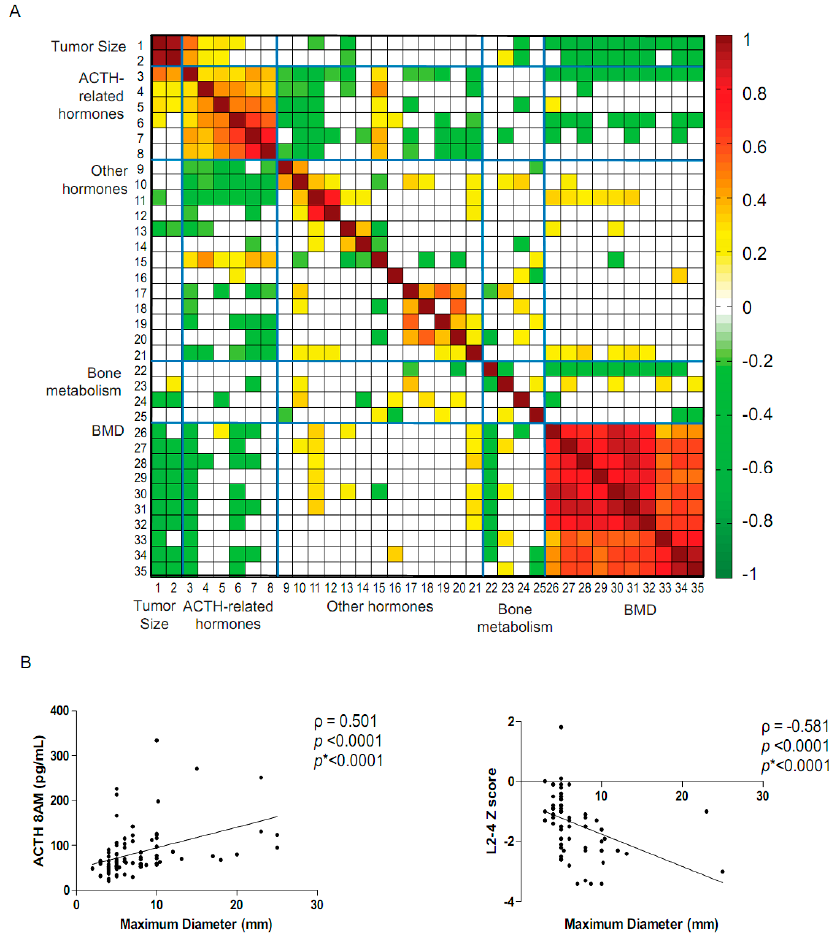
Figure 1. Adrenocorticotrophin (ACTH)-secreting pituitary adenoma tumor size is correlated with pituitary-related hormones and bone mineral density parameters. ( A ) 35 clinical characteristics indices were processed for Spearman’s rank correlation coefficient (SRCC) analysis. These phenotypes were shown in Table S1. The heat map of the SRCC results ( p value < 0.05, false discovery rate (FDR) < 0.05) were generated using Matlab 7.0 software (WathWorks, Natick, MA, USA). Warm colours represent positive correlations, and cold colours represent negative correlations. White indicates no association; ( B ) The Maximum tumor diameter was positively correlated with the 8 Ante Meridiem (AM) plasma ACTH level and was negatively correlated with age-matched bone mineral density (BMD) indices L2–4. Spearman’s rank correlation analysis ( ρ ), the p value and the Benjamini-Hochberg multiple testing correction ( p *) were used to control for the false discovery rate (FDR) and were provided in each graph.